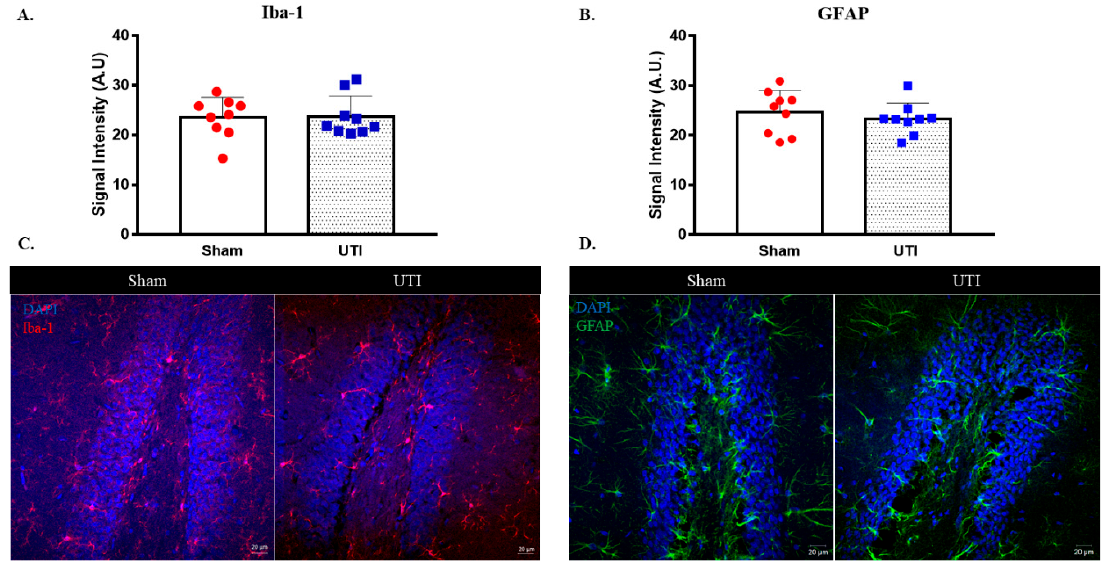
Figure 10. UTI does not induce significant alteration in microglial and astrocytic cells. Signal intensity quantification and representative confocal images for IBA-1 ( A , C ) and GFAP ( B , D )-positive cells in the DG of the sham group and rats with a UTI. Signal intensity was quantified using a Zeiss LSM 710 laser scanning confocal microscope. Unpaired Student’s t -test was used to determine the statistical significance between the sham and UTI